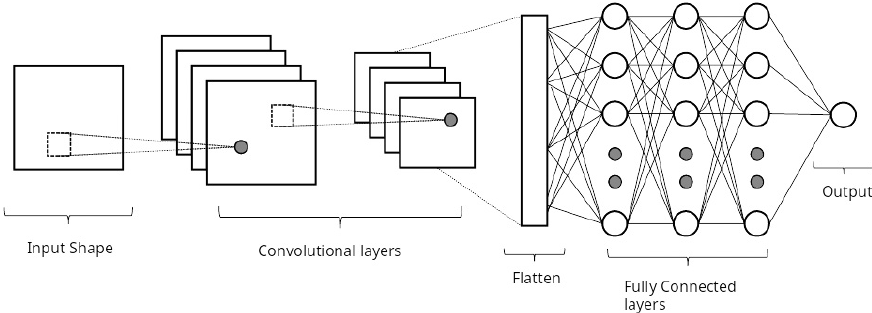
Fig. 1. A high-level overview of